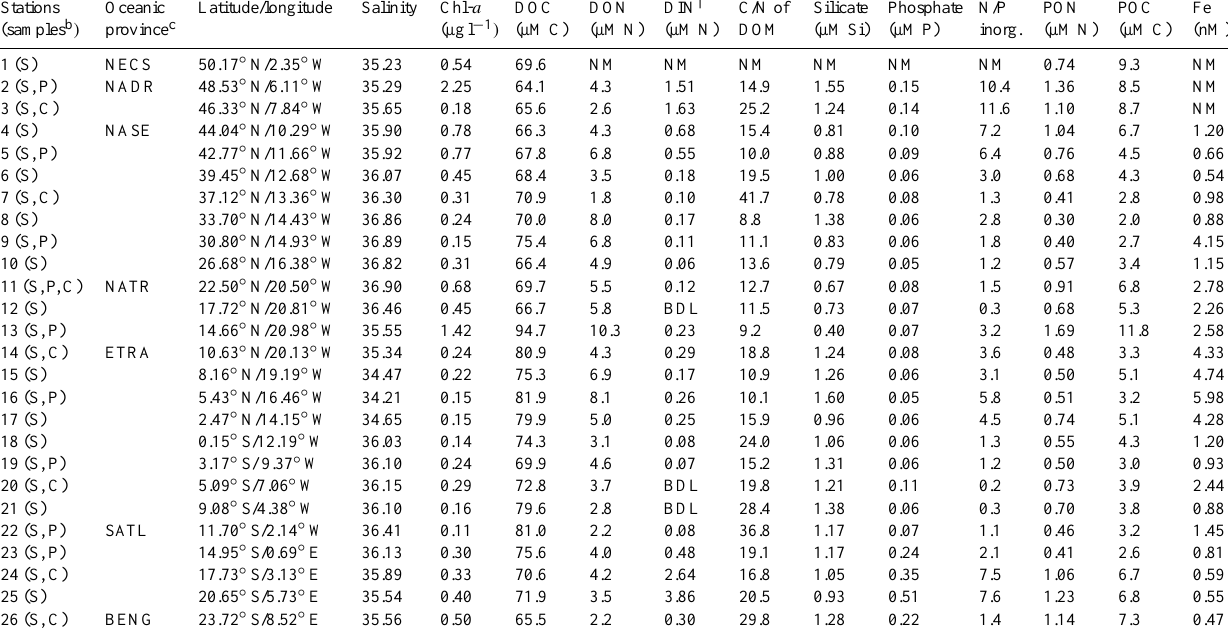
Table 1. Average values of nutrients and selected biogeochemical parameters in different surface (0–10m depth) water samples a . Stations Oceanic (samples b ) province c